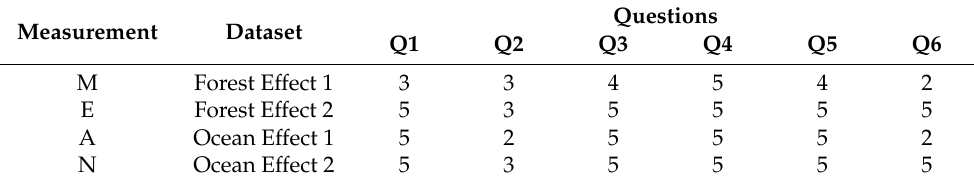
Figure 12. The graphs generated after performing user study for the Ocean and Forest dataset for Effect 1 and Effect 2 ( a ) Graphs for Forest Effect 1 ( b ) Graphs for Forest Effect 2 ( c ) Graphs for Ocean Effect 1 ( d ) Graphs for Ocean Effect 2 and ( e ) Questions for user study. Table 4. The user study results for the Forest and Ocean Videos with Effect 1 and Effect